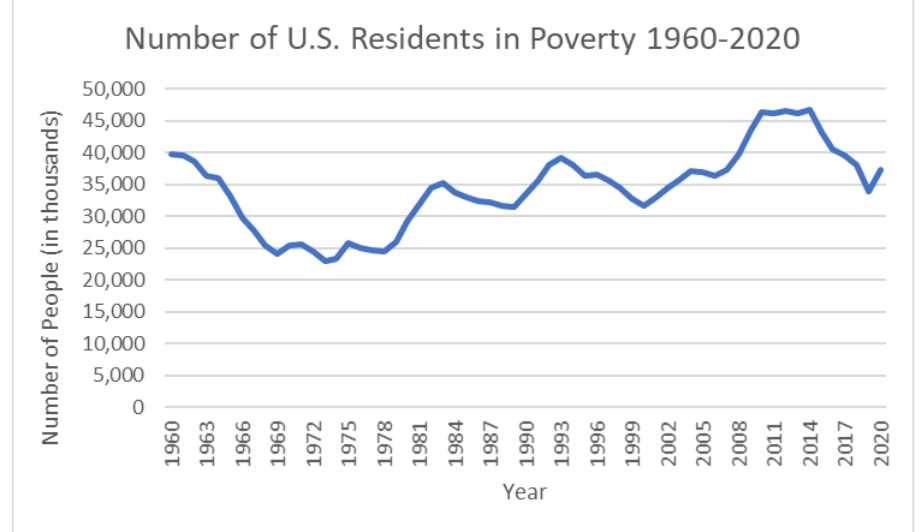
Figure 1. Number of US residents in poverty (in thousands), 1960–2020. Chart by Hunger Free America, based on publicly available US Census Bureau Data